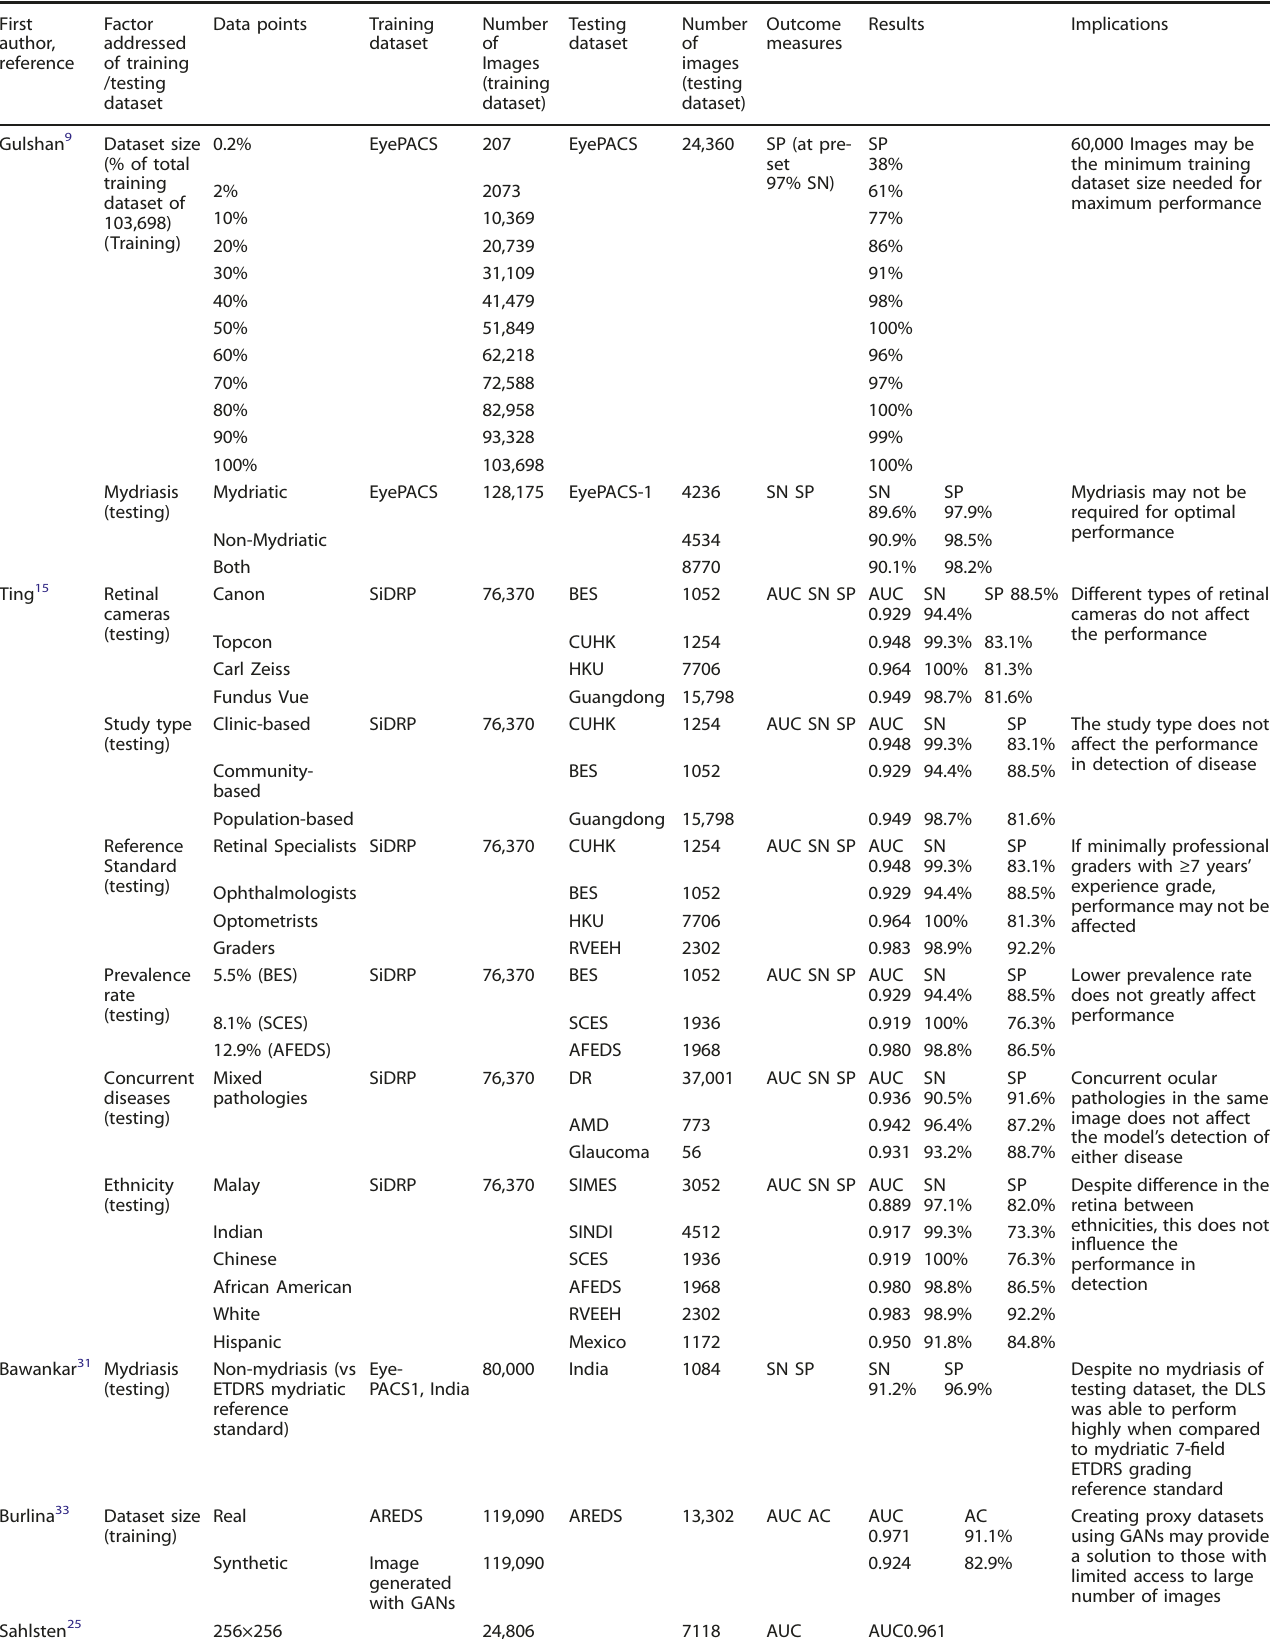
Table 2. Characteristics of included studies in systematic